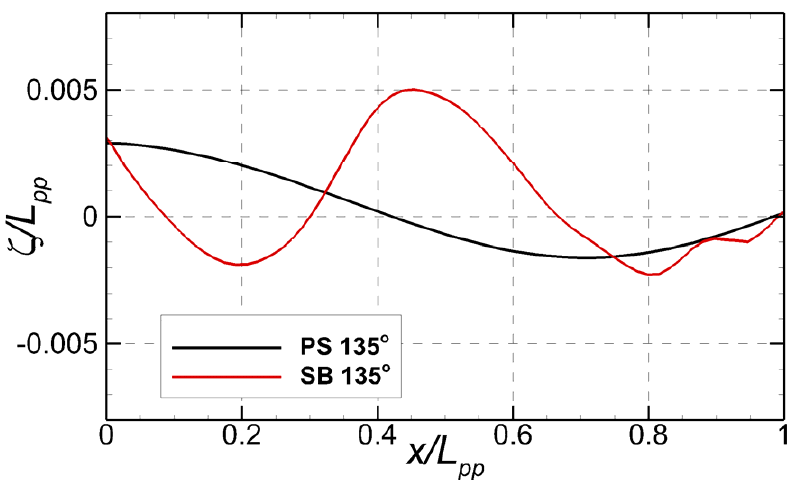
Figure 14. Wave profiles on the hull.